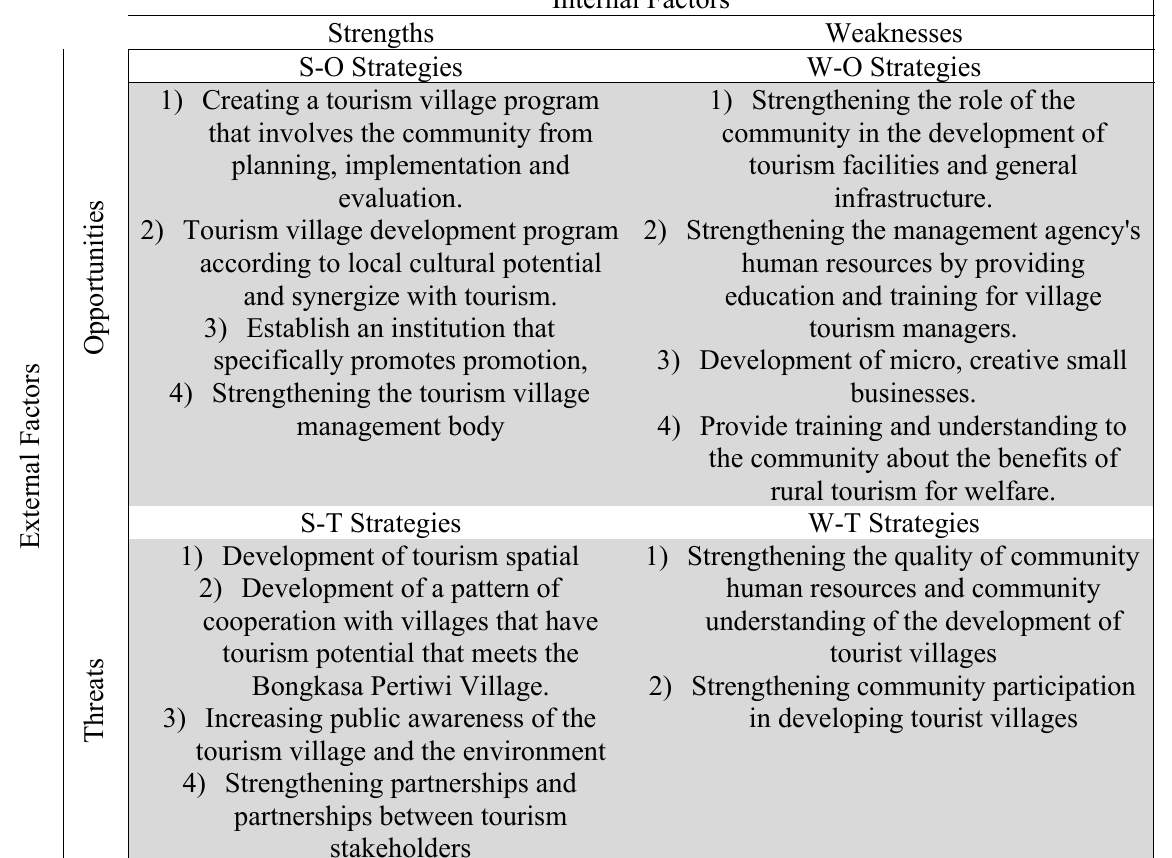
SWOT Diagram of Potential Development of Bongkasa Pertiwi Tourism